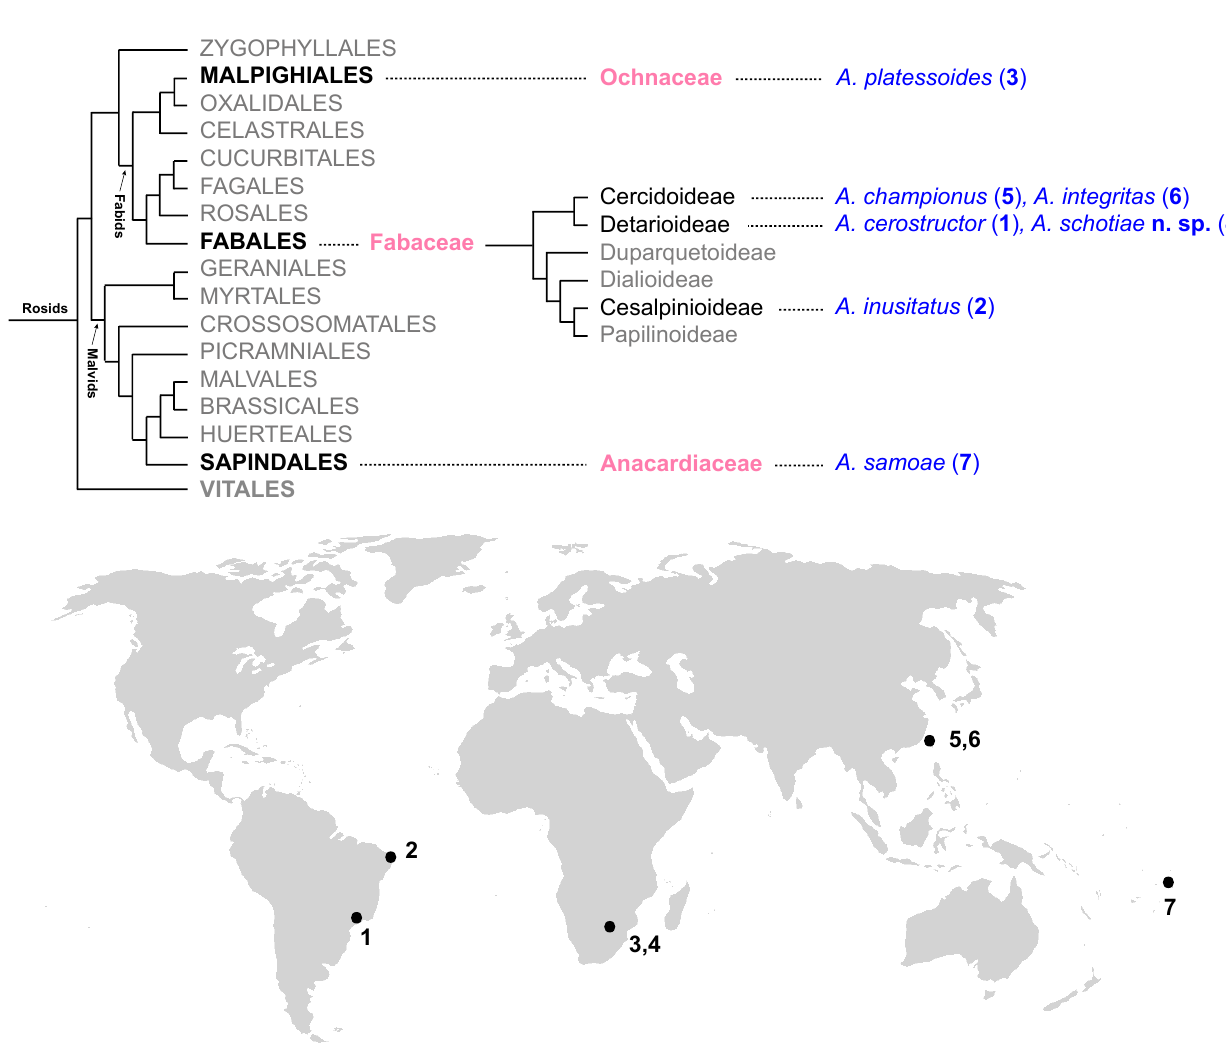
Figure 2. Distribution of Aberoptus spp. (blue) on the plant phylogeny (above) and findings of Aberoptus spp. in the world (below). The plant phylogeny follows [55]. Three host plant families are marked pink; phylogenetic relations between fabacean subfamilies follows [56]. Numbers in the map correspond to Aberoptus spp. indicated in the upper part of the